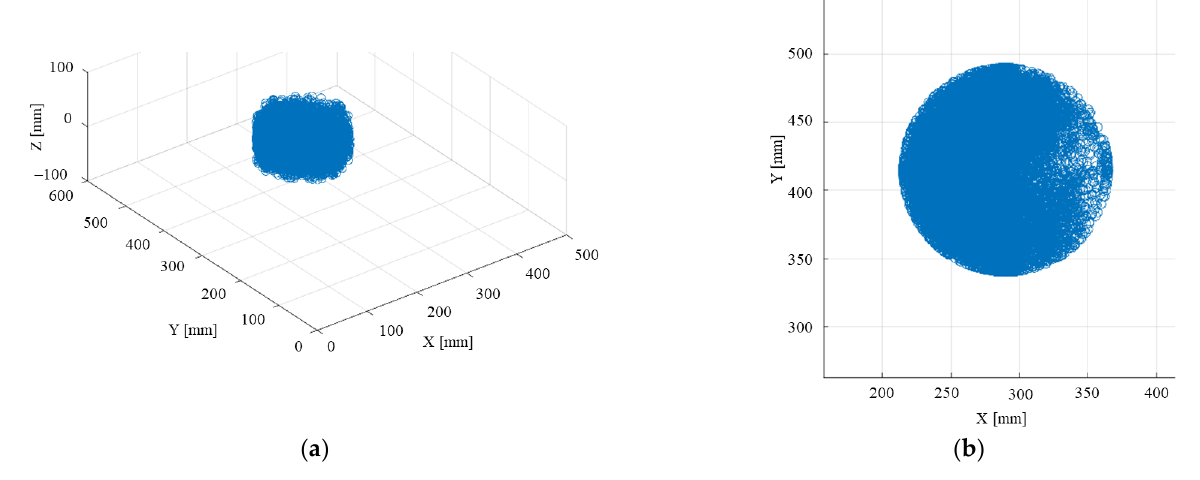
Figure 15. Point cloud spanned by the solution set SOLS(m) (m = 1,…,28,568): ( a ) isometric view; ( b ) Z axis view.